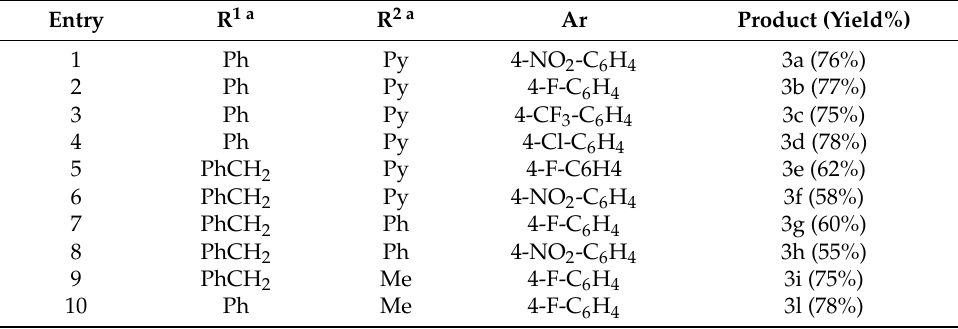
Figure 5. Reaction of nitrones 1a − e with isocyanates 2a − d. Reagents and conditions: (a) anhydrous acetone, room temperature, 5 h, 58–78% yields. Table 1. Synthesis of 1,2,4-oxazolidinyl-5-ones 3a–l by 1,3-dipolar cycloaddition.